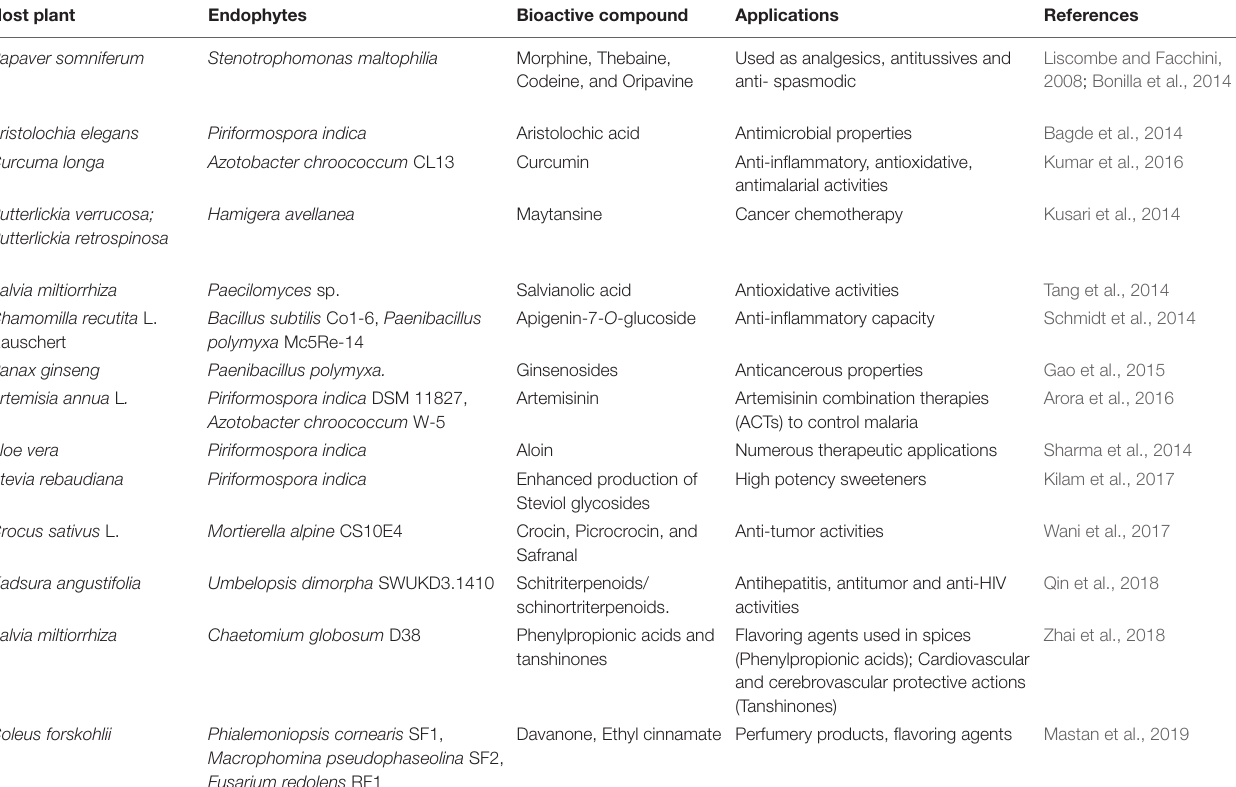
TABLE 5 | Bioactive compounds enhancement in host plants by